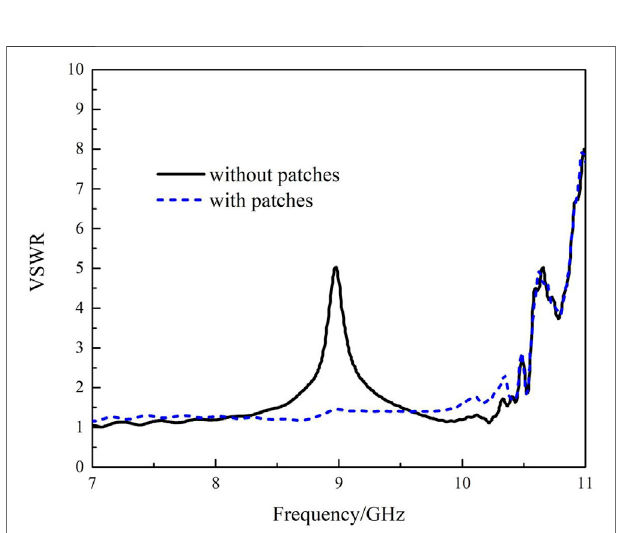
FIGURE 6 | Schematic structure of (A) the proposed device, (B) the feeding network and (C) the composite unit.